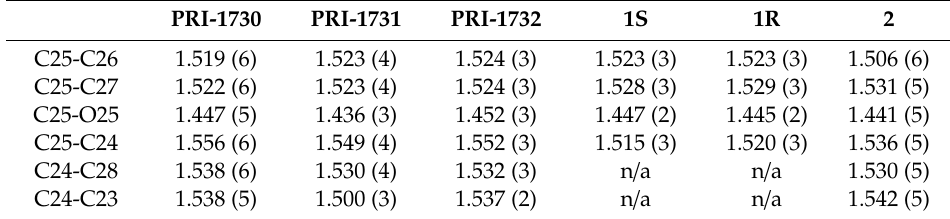
Table 1. Geometry analysis of side chain of analogues of vitamin D and corresponding bonds from 1 and 2 . Bond lengths given in Å.